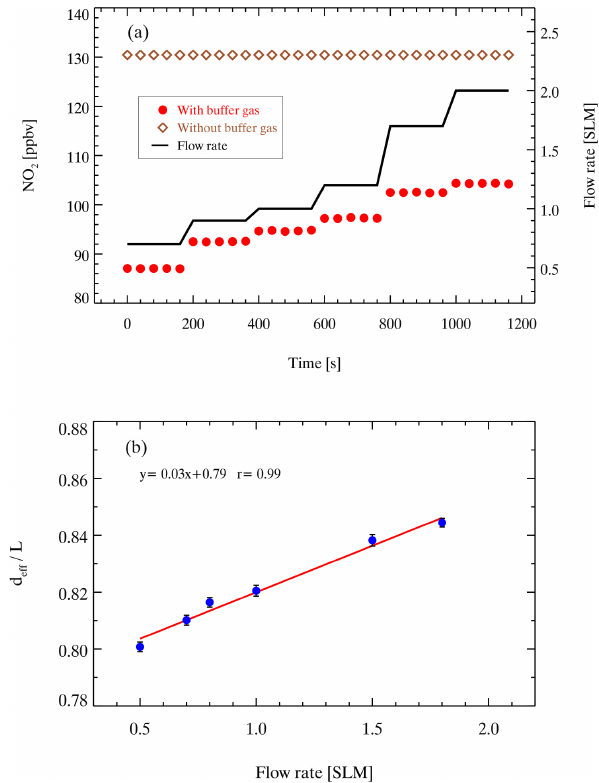
Figure 3. The results of the effective cavity length. (a) The black line represents the flow rate, and the red points and brown dia- monds represent the retrieved NO 2 concentration with and without nitrogen purge (100sccm × 2), respectively. (b) The relationship be- tween the ratio of the effective cavity length ( d eff ) to cavity physical distance ( L ) and the sampling flow